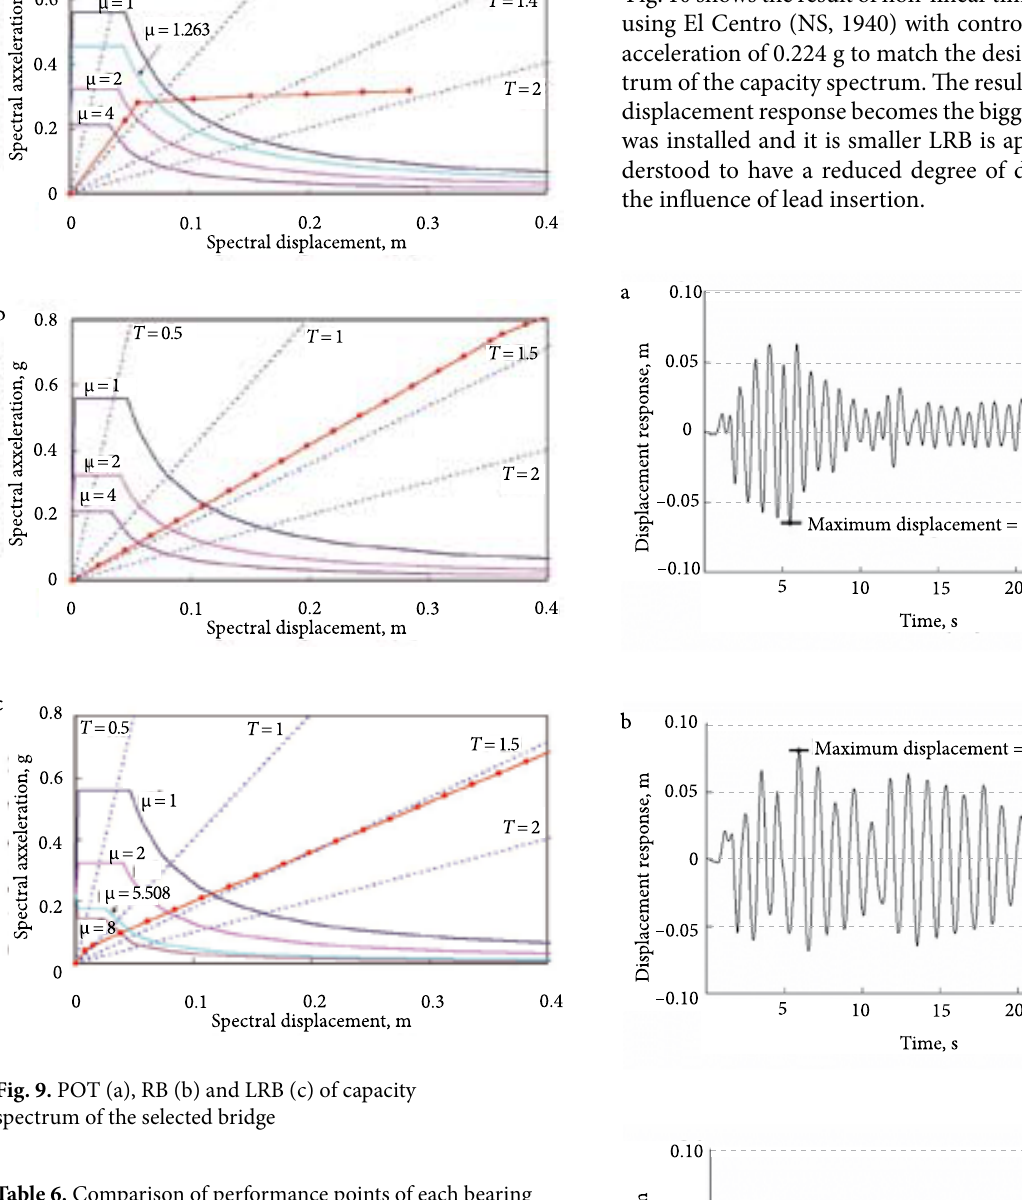
Table 6. Comparison of performance points of each bearing (collapsing prevention)